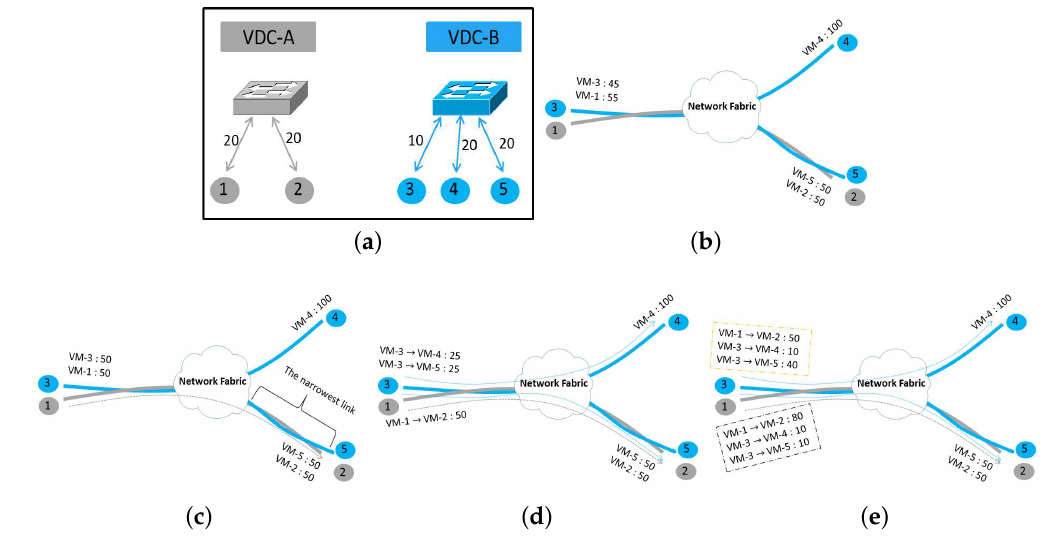
Figure 6. The bandwidth allocation mechanism. ( a ) The VN demands; ( b ) Initial allocation; ( c ) Rate stipulation (1 flow); ( d ) Rate stipulation (3 flows); ( e ) Dynamic flow rate